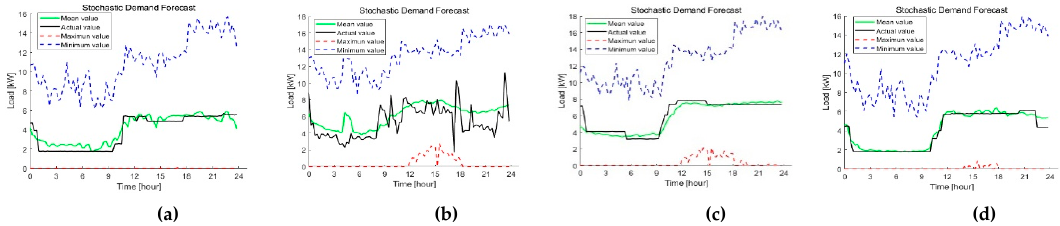
Figure 20. Testbed stochastic demand load forecast. ( a ) Spring, ( b ) Summer, ( c ) Fall, ( d ) Winter.